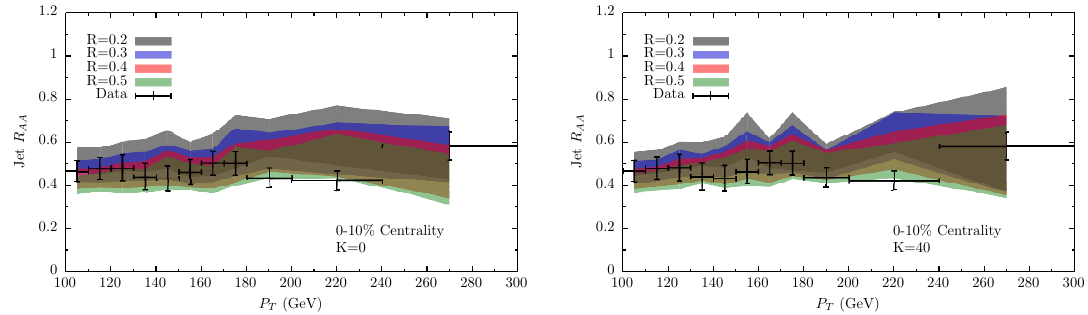
Figure 2 . Dependence of R jet on the anti- k t jet reconstruction parameter R for K = 0 (no AA broadening, left panel) and K = 40 (right panel). For comparison, we show the suppression of jets reconstructed using the anti- k t algorithm with R = 0 : 3 as measured by CMS in the same interval of rapidity